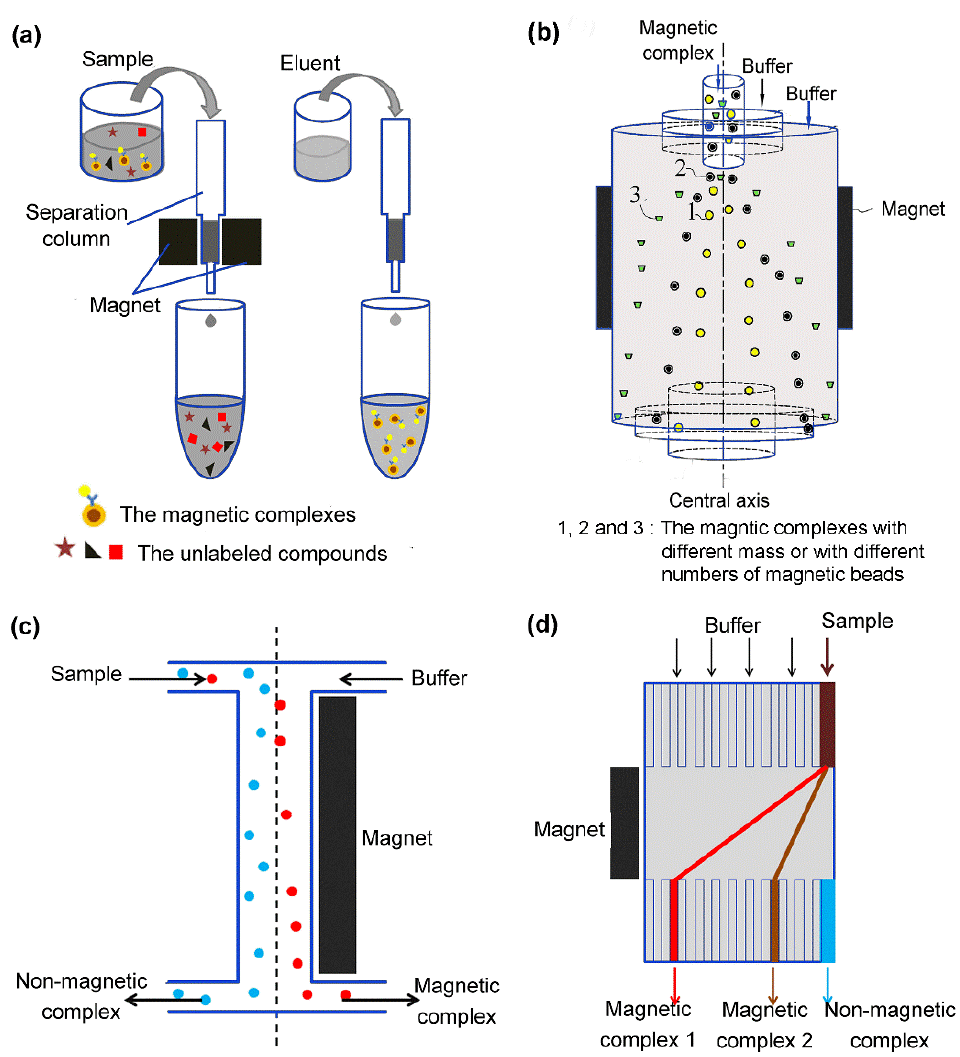
Figure 6. ( a ) The basic principle of the immune magnetic beads sorting device. ( b ) The cross-section view of the magnetic separator proposed by Murthy [162]. ( c , d ) The separation principle of the magnetophoresis [163].